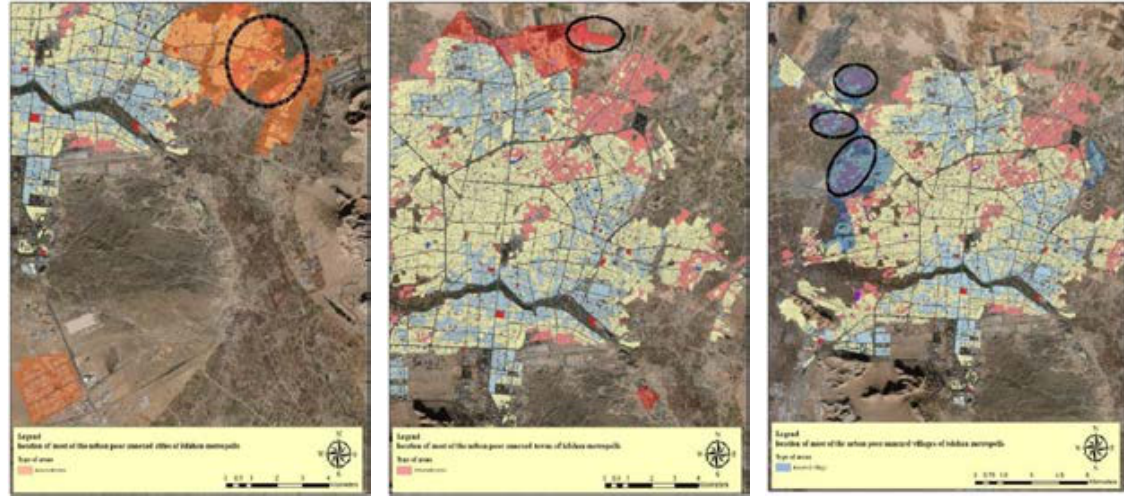
Fig. 13: The spatial concentrations of urban poor (UPRDS) in annexed cities (a), towns (b) and villages (c)